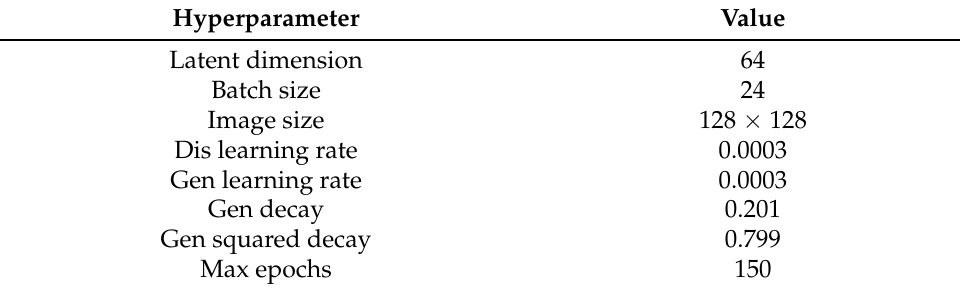
Table 3. Hyperparameters